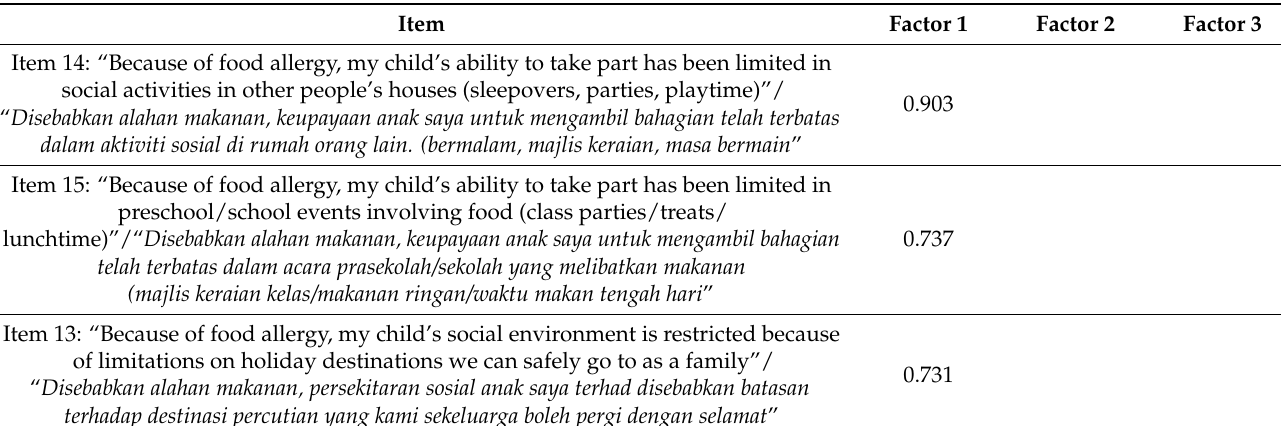
Table 2. Rotated Pattern Matrix on the final three-factor